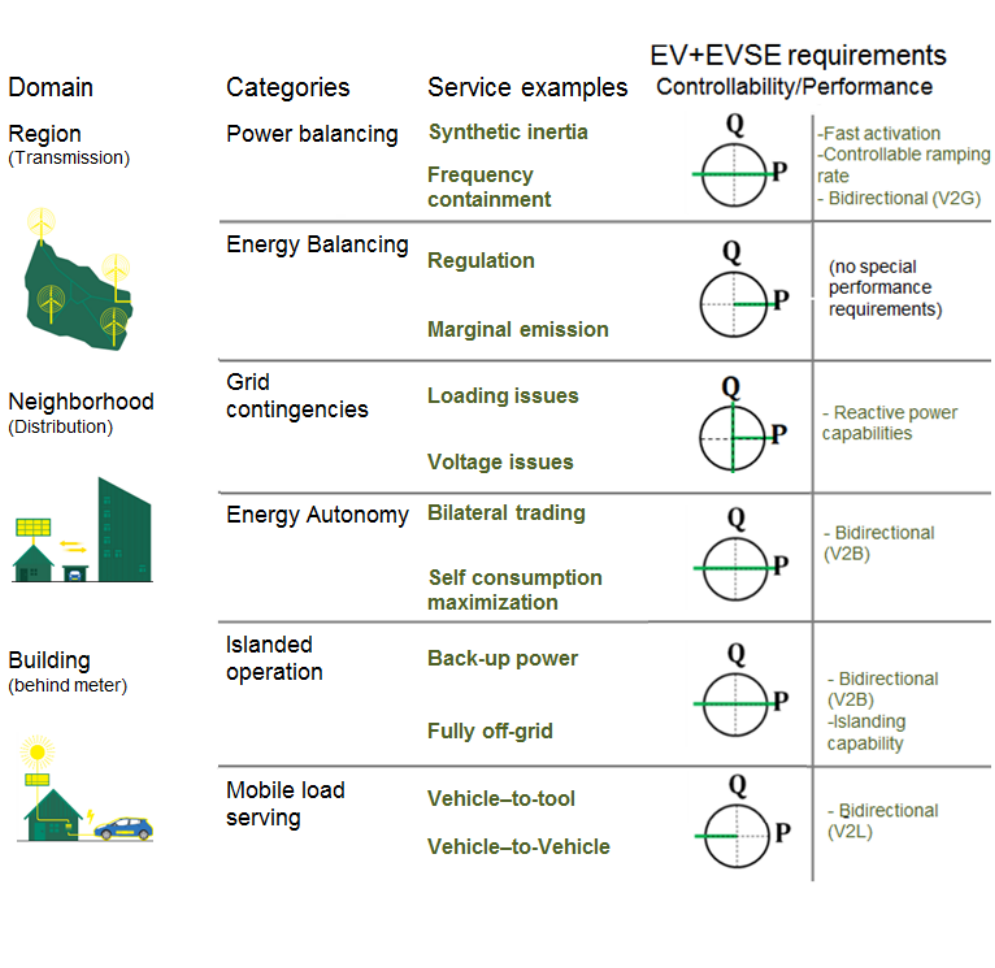
Figure 2. Parker service